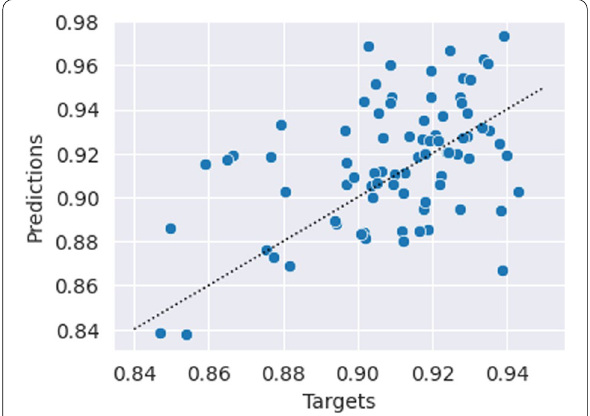
Fig. 4 Predicted vs. target Dice values of the deep network shown in Fig. 2. The dotted line indicates perfect x